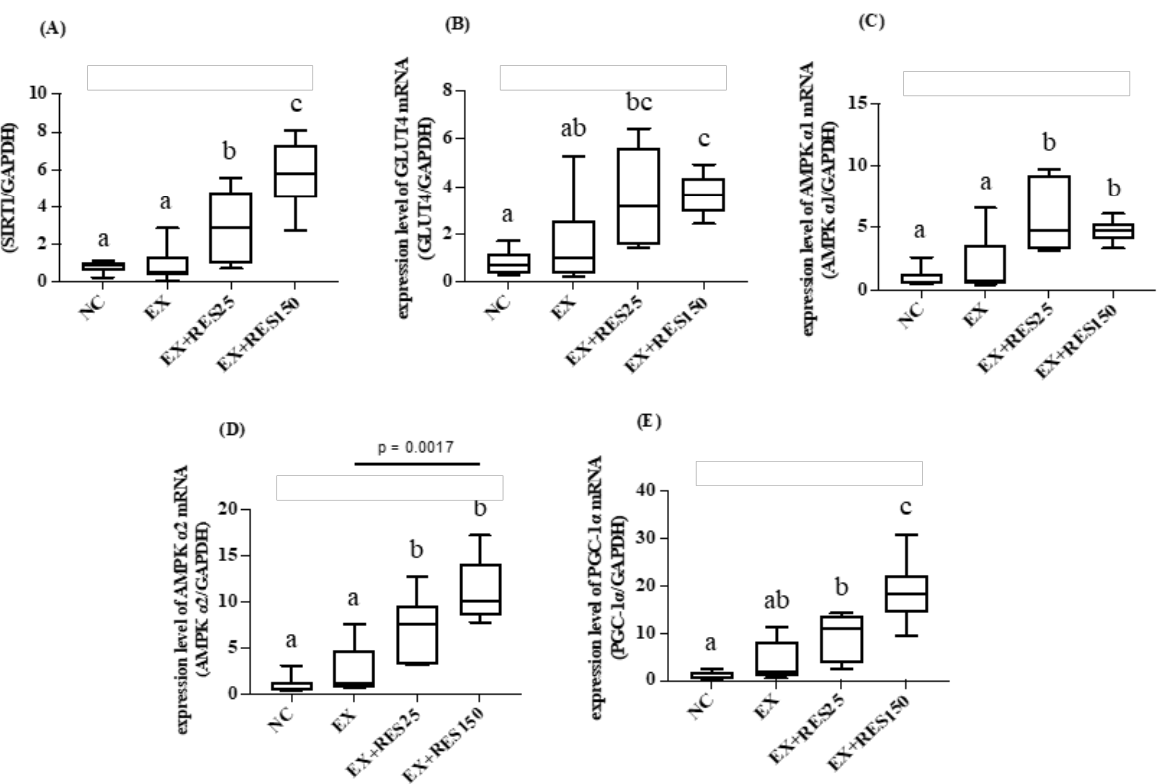
Figure 5. Effects of resveratrol on energy utilization and antioxidative mRNA expression in gas- trocnemius muscle during short-duration downhill running. ( A ) Sirt1 mRNA ( B ) Ampk α 1 mRNA ( C ) Ampk α 2 mRNA ( D ) Glut4 mRNA ( E ) Pgc1 α mRNA. mRNA expression was normalized to GAPDH and is expressed in terms of fold change relative to the control group. NC: control ( n = 6); EX: exercise ( n = 6); EX + RES25: exercise with resveratrol 25 mg/kg ( n = 6); EX + RES150: exercise with resveratrol 150 mg/kg ( n = 6). Data are presented as mean ± SEM. Data were analysed using one-way analysis of variance and a t-test followed by the Bonferroni multiple comparison test. Superscript letters (a,